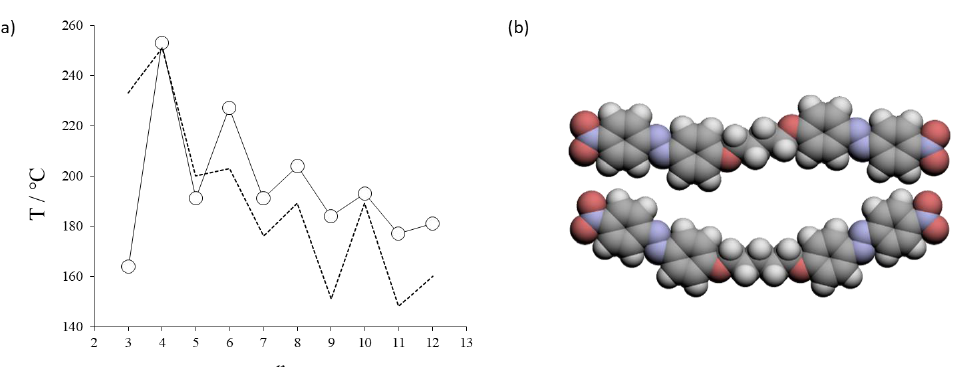
Figure 1. ( a ) The dependence of the nematic-isotropic transition temperatures, T NI , on the number of methylene groups, n , in the flexible spacer for the BNABO n series [7]. The circles indicate T NI , and the broken line joins the melting points. ( b ) Molecular shapes of BNABO4 (upper) and BNABO5 (lower).